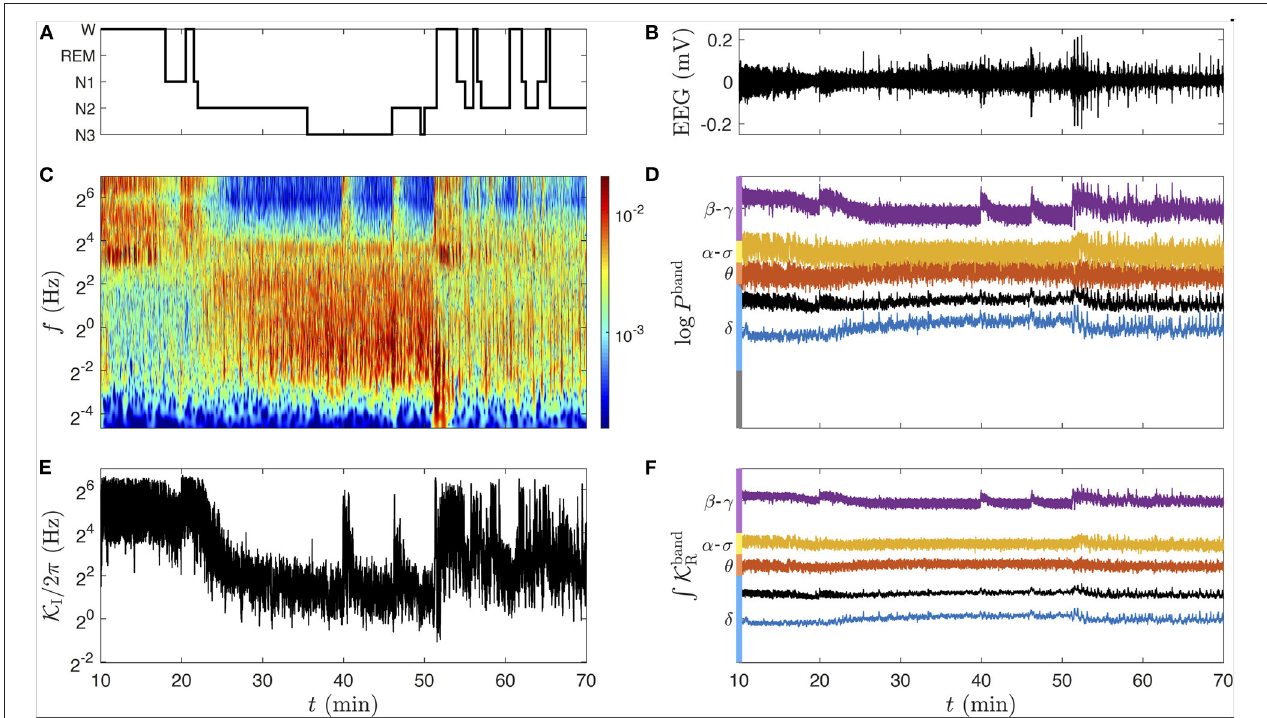
FIGURE 7 | Modulation analysis extended to the EEG. (A) Hypnogram of the subject slp04 of slpdb during a sleep cycle: the subject falls asleep around 20 min and wakes up around 50 min. (B) EEG signal (C3-O1) in black line. (C) Color-coded amplitude of the EEG signal CWT (twice the modulus) during the selected time interval, computed with a quality factor Q 5. The color bar gives the amplitude in millivolt. (D) Natural logarithm of the EEG band powers defined in the text and in = Equation (13): P δ in blue, P θ in red, P α - σ in orange, P β - γ in purple. The black line is the power integrated on the full frequency range (from 0.04 to 125 Hz), P EEG . (E) Average instantaneous frequency K EEG I / 2 π on the full frequency range. (F) Average rate of exponential growth K band R computed in the same frequency bands as in (D) . In (D,F) , the central value of each signal has been aligned to the position in (C,E) of the middle frequency of its band. These signals have no dimension and are scaled in the same